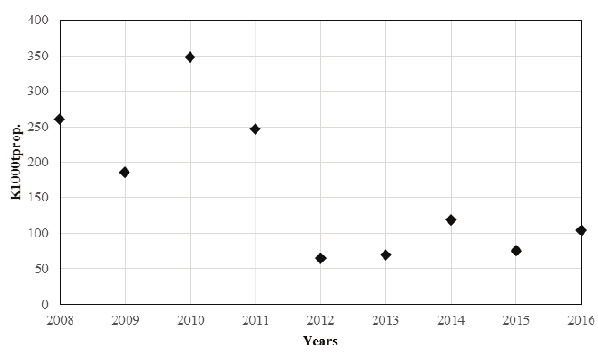
Fig. 14. Changes of the coefficient K